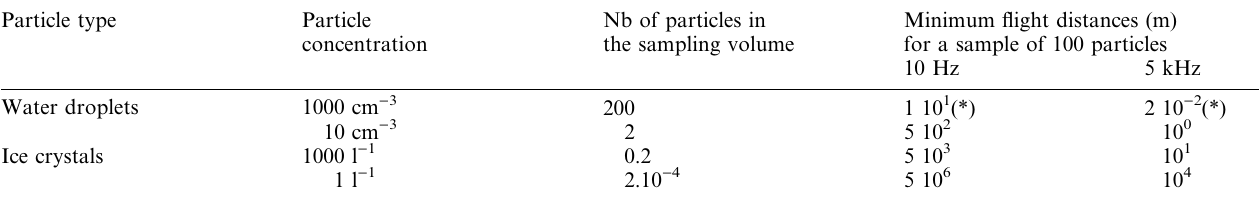
Table 1. Number of particles simultaneously present in the sampling volume and minimum flight distances (or spatial resolutions of the instrument) in order to sample 100 particles as a function of the particle concentration and acquisition rate ( f ) assuming an airspeed ( V a ) of 100 m s ) 1 . (*The lowest value of the spatial resolution is determined by the ratio of V a to f )